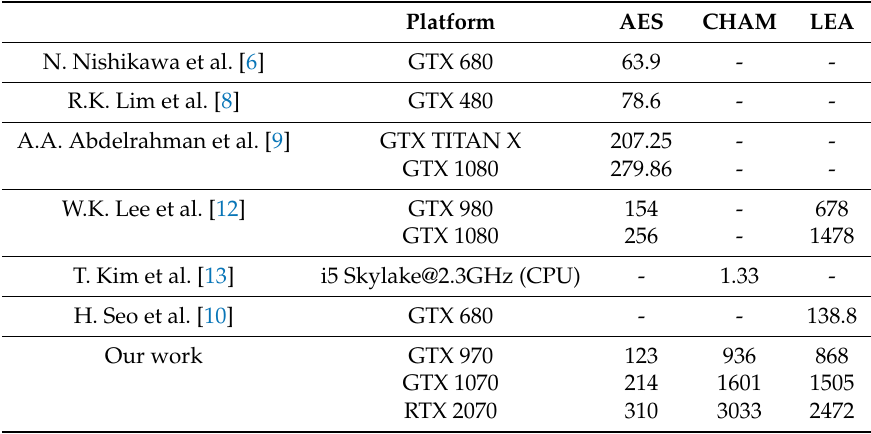
Table 8. Throughput comparison with existing implementations